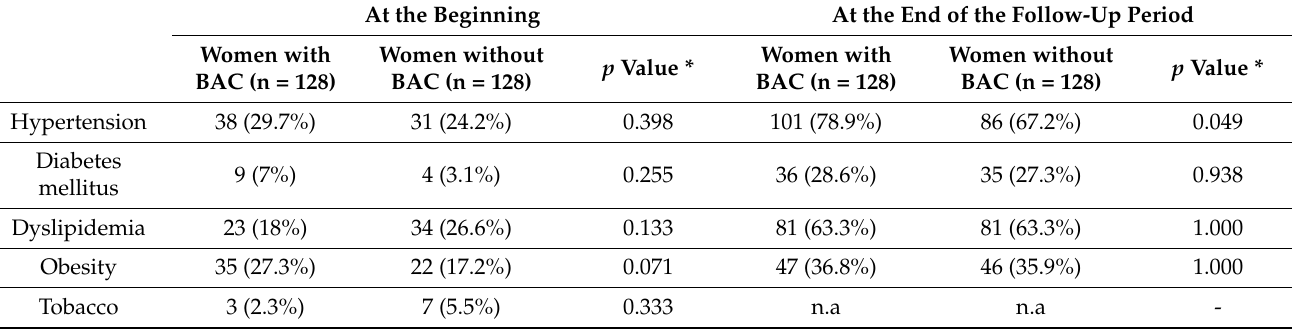
Table 1. Clinical- pathological characteristics of the 128 patients in each group at the beginning and the end of the follow-up